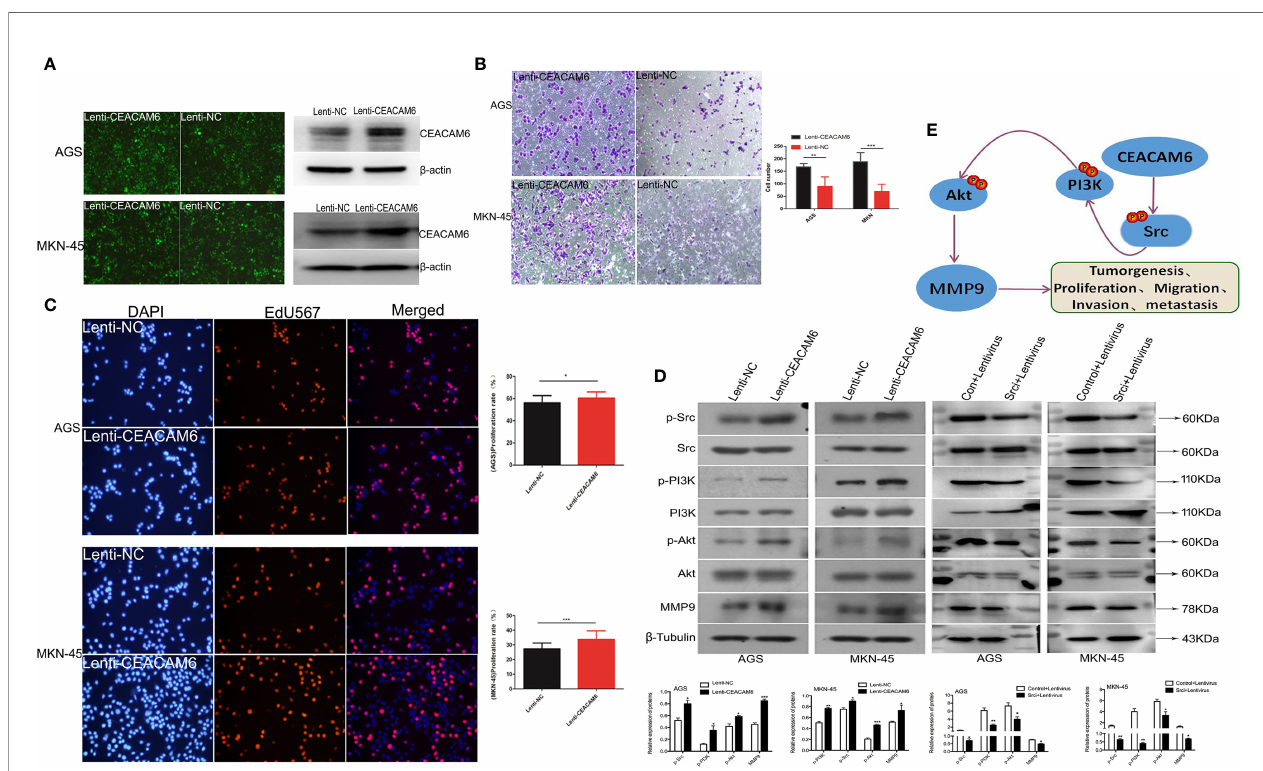
FIGURE 3 | CEACAM6 promoted the GC cells invasion, proliferation and metastasis. (A) AGS and MKN-45 cells were infected with CEACAM6 lentivirus (Lenti- CEACAM6) or negative control lentivirus (Lenti-NC), the cells infected with lentivirus were showed in green color when checked with fl uorescent microscopy, and the infection ef fi ciency was also checked with western-blot. (B) After 48 h of infection, 2.5x10 4 cells were trypsinized and seeded in 24 − well plates with matrigel − coated membranes for the invasion assays. The upper panel represented the AGS cells and the down panel represented the MKN-45 cells. The number of cells in 10 randomly selected fi elds was counted at 48 h after incubation. Data represents the mean value of three independent experiments. Bars represent the mean (± SEM) number of invaded cells per fi eld. **P < 0.01, ***P < 0.001. (C) 3x10 4 cells/ml were seeded in 96 − well plates and grown for 24 h and then infected with Lenti- CEACAM6 and Lenti-NC for 48 h. Cells were stained with EdU − Apollo 567 and DAPI; DAPI blue fl uorescence represents all live cells and the EdU − Apollo567 red fl uorescence represents the proliferating cells. The number of cells in 10 randomly selected fi elds were counted. The proliferation ratio was calculated as number of proliferating cells/total number of cells x 100%. Mean (± SEM) values of three independent experiments are presented.*p<0.05, ***p<0.001. (D) Western-blot assays were performed to detect the expression of PI3K, p − PI3K Akt, p − Akt, Src, p-Src and MMP9. b − Tubulin was used as the internal control for total proteins, while total protein was used as the internal control for the phosphorylated protein. Mean (± SEM) values of three independent experiments are presented, *p<0.05, **P<0.01, ***p<0.001. Control: Src inhibitor control, Lentivirus: CEACAM6 over expression lentivirus (Lenti-CEACAM6), Srci:Src inhibitor. (E) The possible pattern graph of CEACAM6 to Src/PI3K/Akt signaling